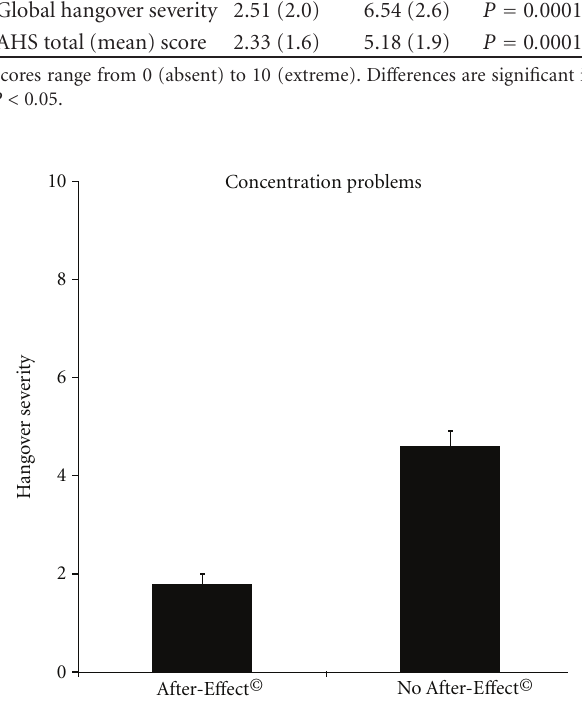
Figure 3: Severity of concentration problems with and without using After-E ff ect © .